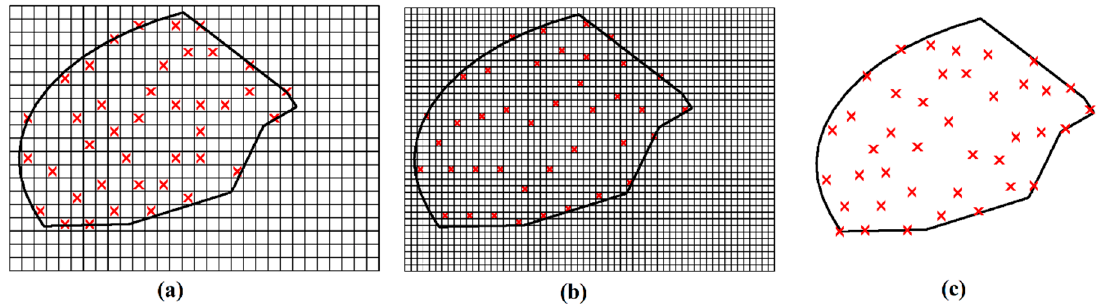
Figure 8. Comparison of optimal wind farm layouts of 40 turbines by: ( a ) 20 × 30 grid method, ( b ) 40 × 60 grid method, and ( c ) coordinate method.